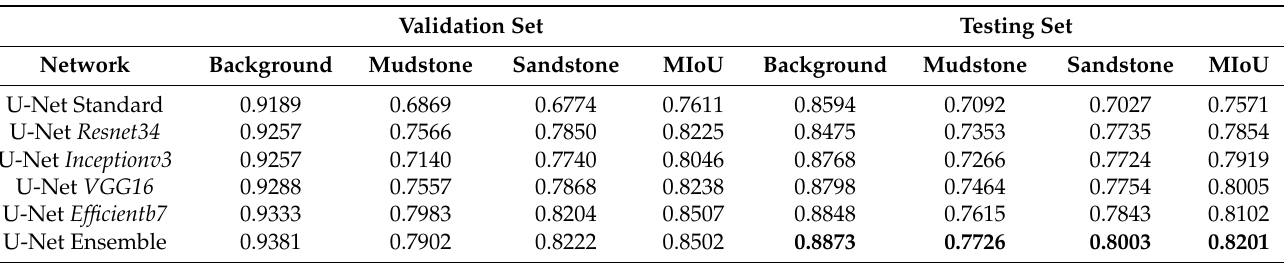
Table 2. Performance evaluation of U-Net models for validation and test sets. The best test results are presented in bold.